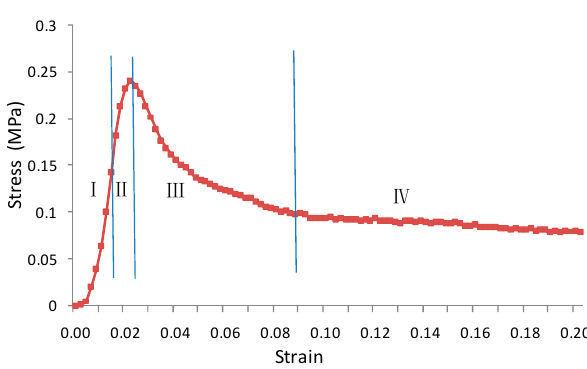
Figure 4. Typical stress–strain curves of sandwich structure with a Taiji honeycomb core under out-of-plane compression.